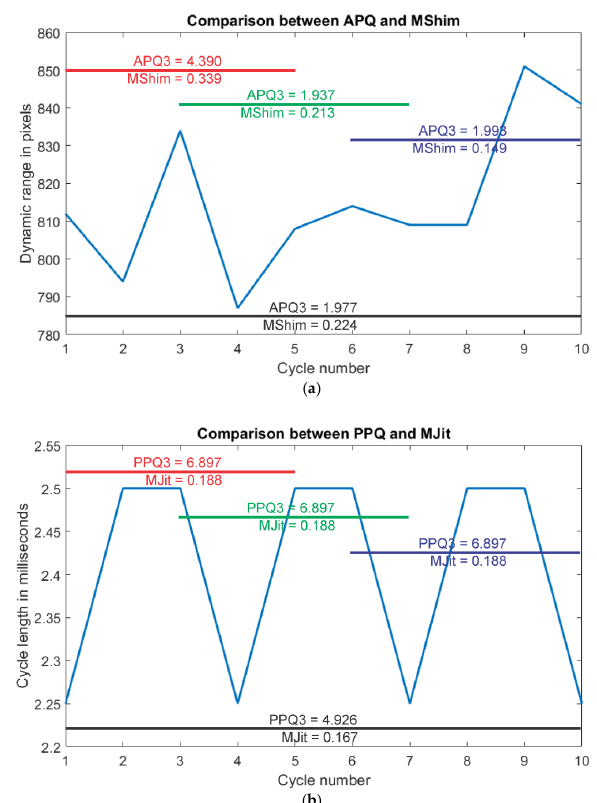
Figure 8. ( a ) Dynamic ranges of ten consecutive cycles (bright blue line). Amplitude Perturbation Quotient-3% (APQ3) and Mean Shimmer (MShim) are calculated for different intervals of the total range (red, green, dark blue and black line). ( b ) Cycle lengths of ten consecutive cycles (bright blue line). Period Perturbation Quotient-3% (PPQ3) and Mean Jitter (MJit) are calculated for different intervals of the total range (red, green, dark blue and black line).